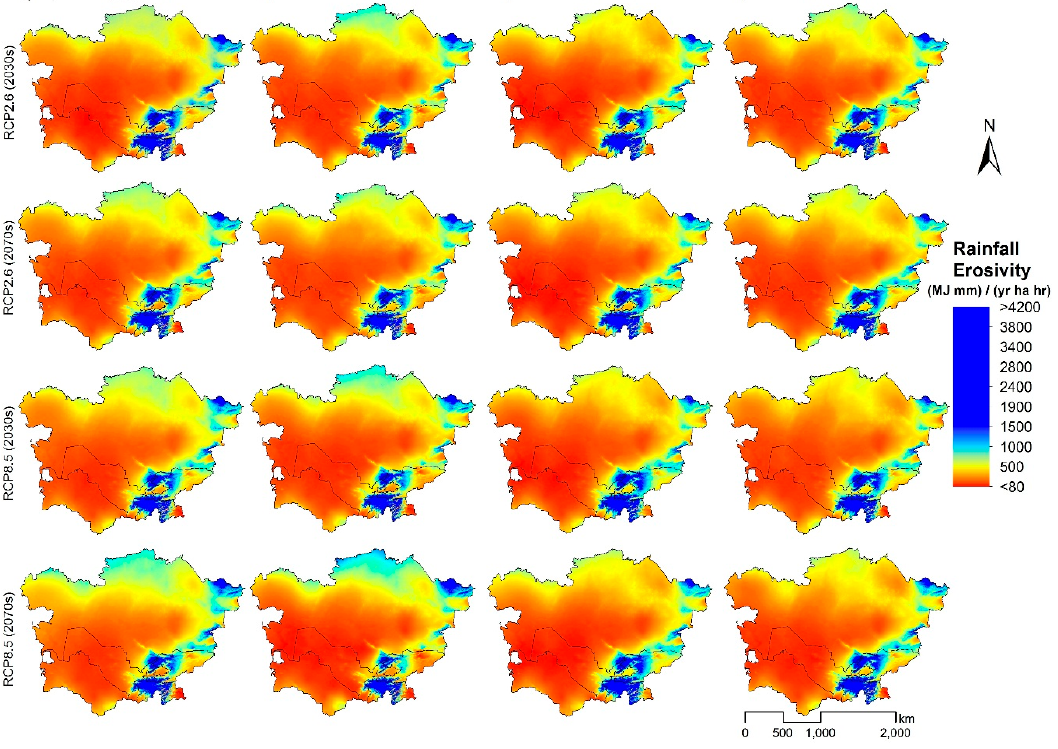
Figure 5. Rainfall erosivity projections for the period 2030s and 2070s according to RCP2.6 and 8.5 scenarios driven by the BCCCSM1.1, IPSLCM5ALR, MIROC-5, MPIESMLR GCM models. In Kazakhstan, we calculated the mean values of rainfall erosivity of 374.3 MJ mm ha − 1 h − 1 year − 1 during the baseline period. From MIROC5, BCCCSM1.1 and MPIESMLR (both scenarios), we noted